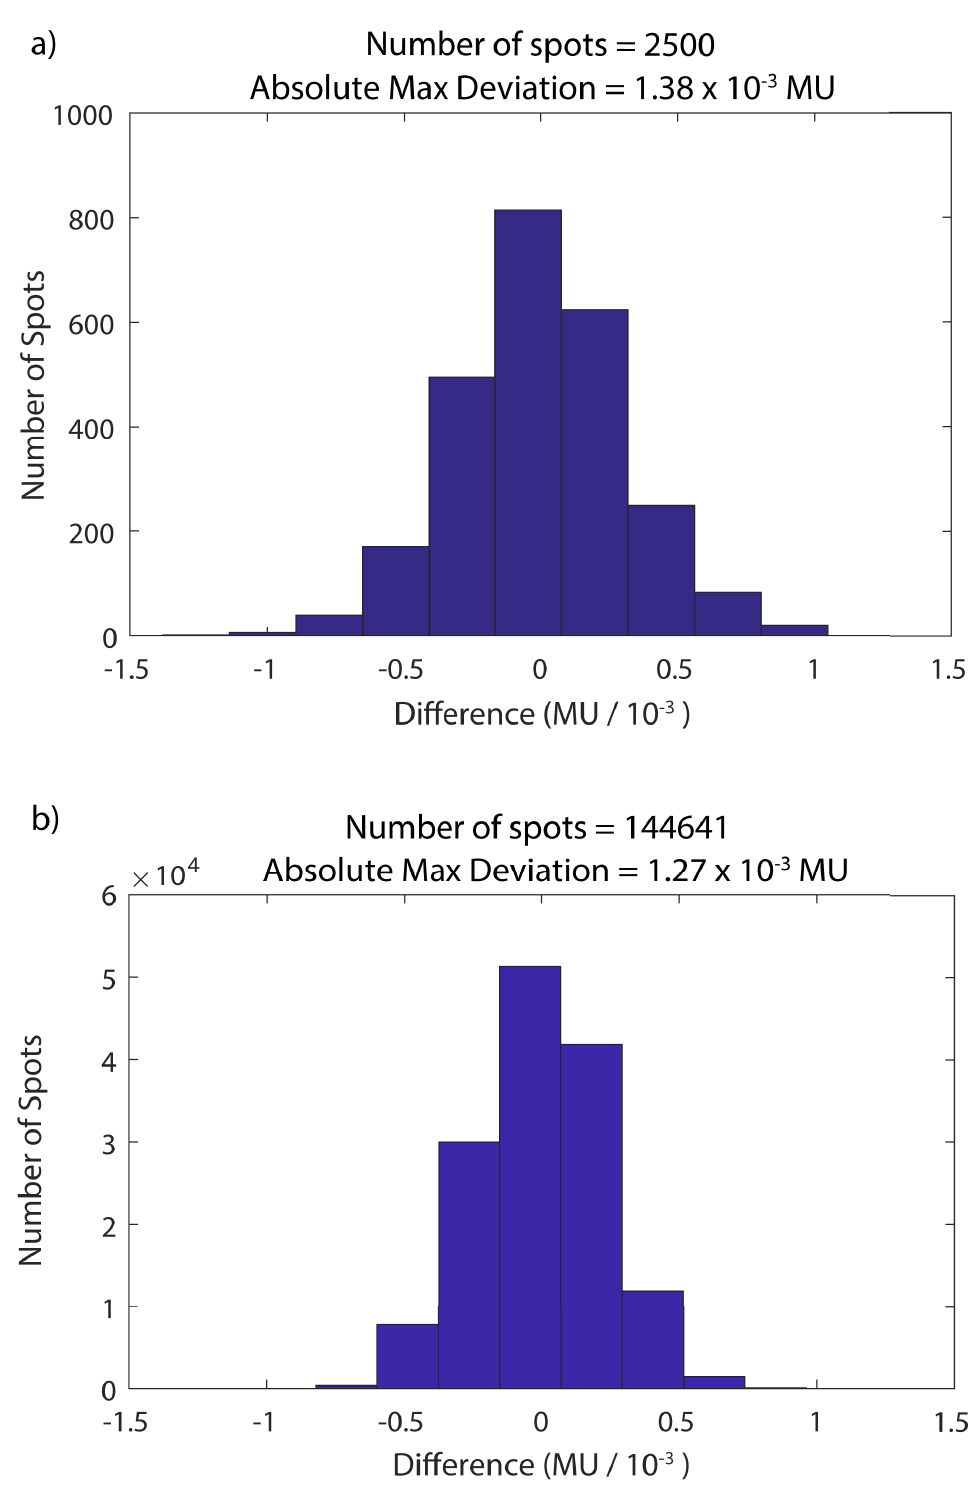
Fig 2. MU difference histograms for prostate (a) and liver (b) fields. The difference between the planned and delivered MU are analyzed spot-by-spot to verify that predefined action thresholds have not been exceeded.